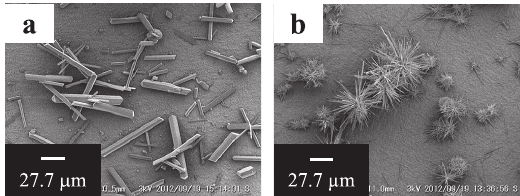
Fig. 3 SEM photographs of alanine and glycine particles by the non-inkjet process: (a) glycine particles using 1-butanol, (b) alanine particles using 1-butanol. Reprinted with permission from Ref. (Tamura et al., 2014). Copyright: (2014) Elsevier.